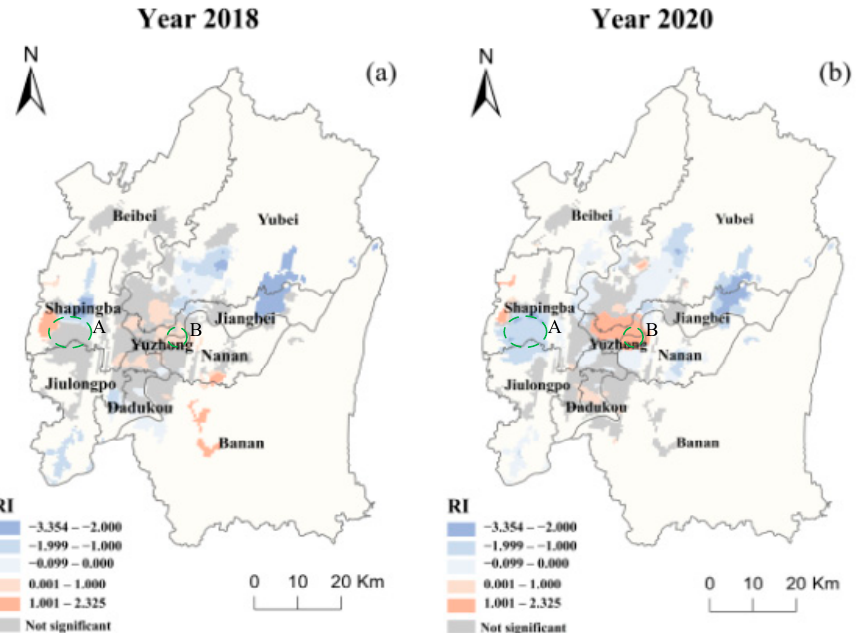
Figure 5. Spatial distributions of the coefficients of residential index in ( a ) 2018 and ( b ) 2020 (RI: residential index; Region A is the residential agglomeration in Shapingba; Region B is the residential agglomeration in Yuzhon).